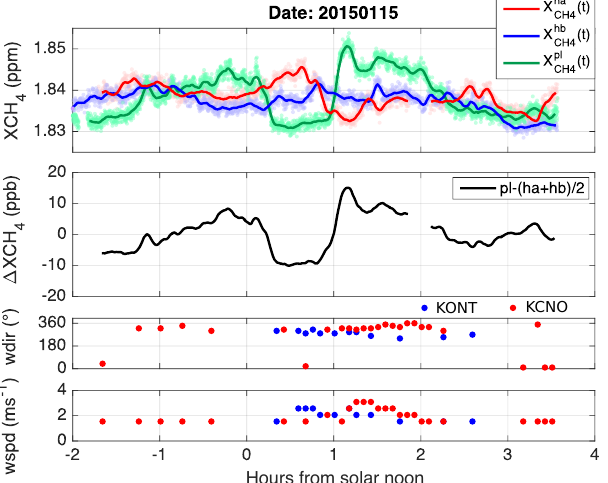
Figure G1. The cross covariance function (mean-removed cross correlation) between X CH and X CO for individual sites measured 4 2 with ha and hb are shown in first and second panels. The lagged cross covariance between (cid:49)X CH and (cid:49)X CO (third panel) has a 4 2 larger value at zero lag compared to the first and second